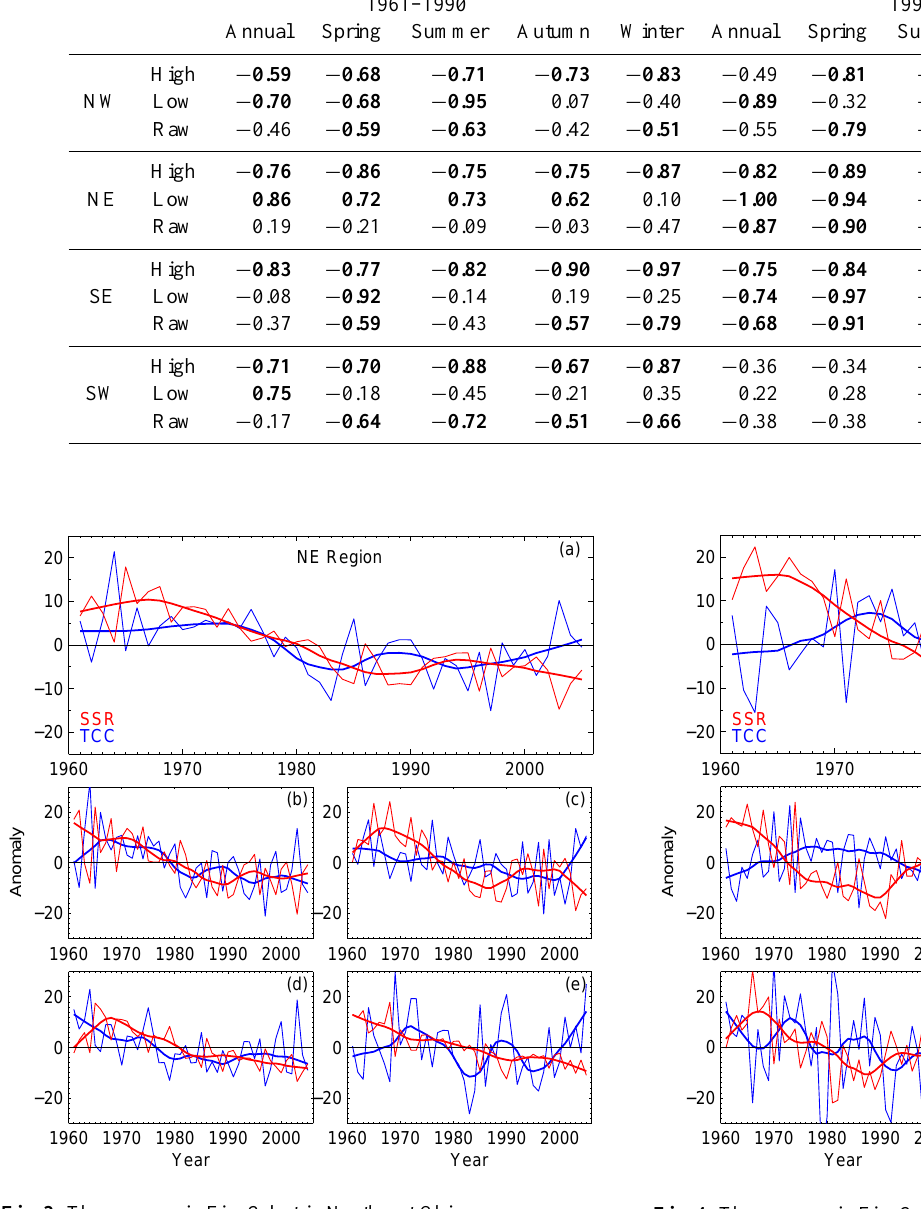
Fig. 3. The same as in Fig. 2, but in Northeast China. Fig. 4. The same as in Fig. 2, but in Southeast